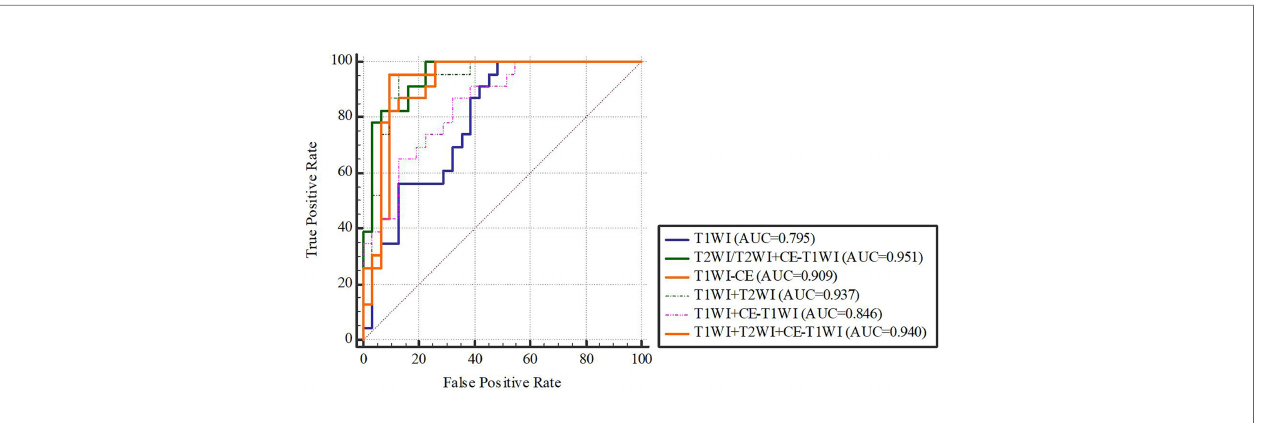
FIGURE 4 | LR-classi fi er in the training cohort.